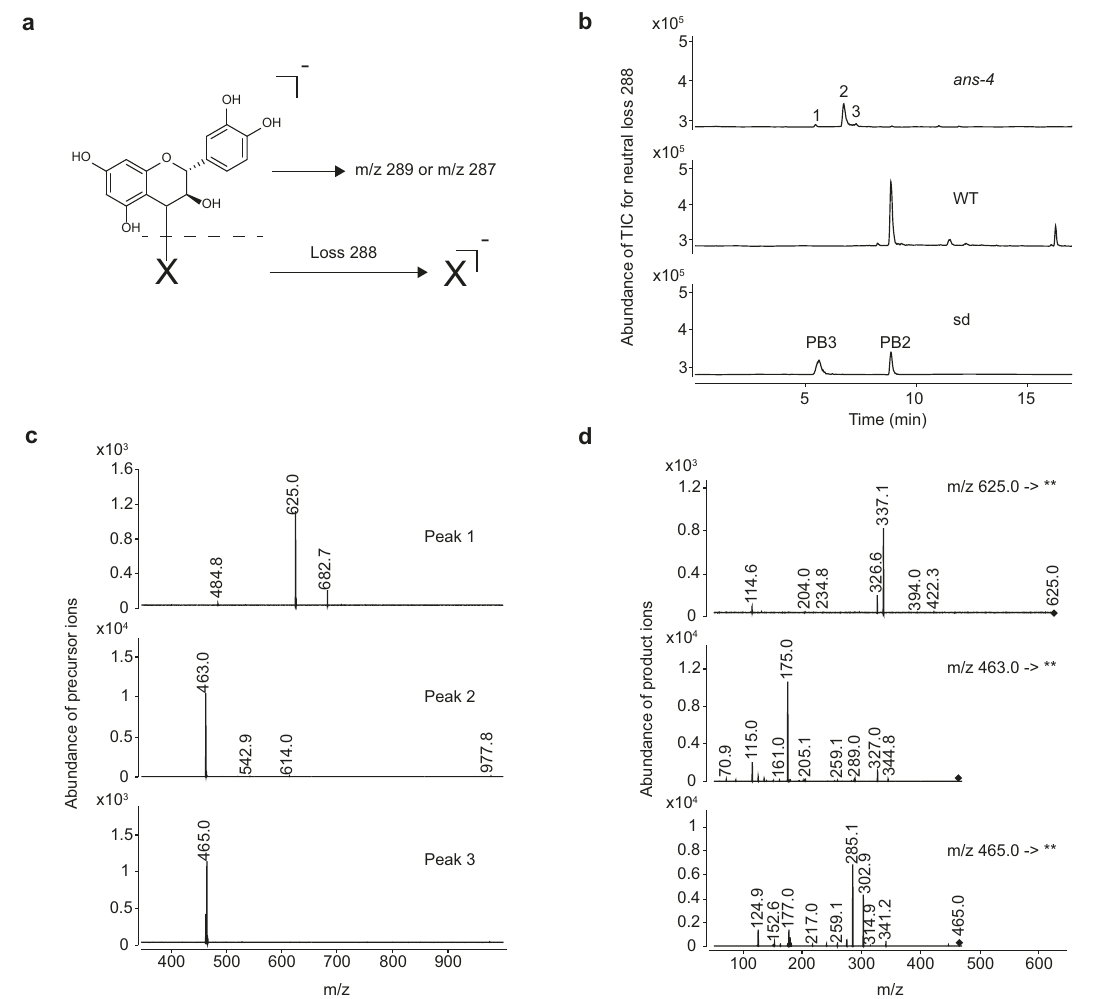
Fig. 3 Screening of compounds with a ( + )-catechin backbone in the A. thaliana ans-4 mutant. a Ion fragmentation schemes for the ( + )-catechin- unknown compound “ X ” adduct in mass spectra. b Neutral loss scan at mass 288 for the soluble PA fraction from 7 DAP siliques of A. thaliana ans-4 mutant and wild-type (WT) plants. Procyanidin B3 (PB3) and procyanidin B2 (PB2) served as positive controls. c m/z of candidate compounds shown in ( b ). d Product ion pro fi les of the compounds at m/z 625, m/z 463 and m/z 465 obtained on Supplementary Fig. 4), and the fragments with m/z at 287.0549 ± 20 ppm and 575.1149 ± 20 ppm were the speci fi c ions